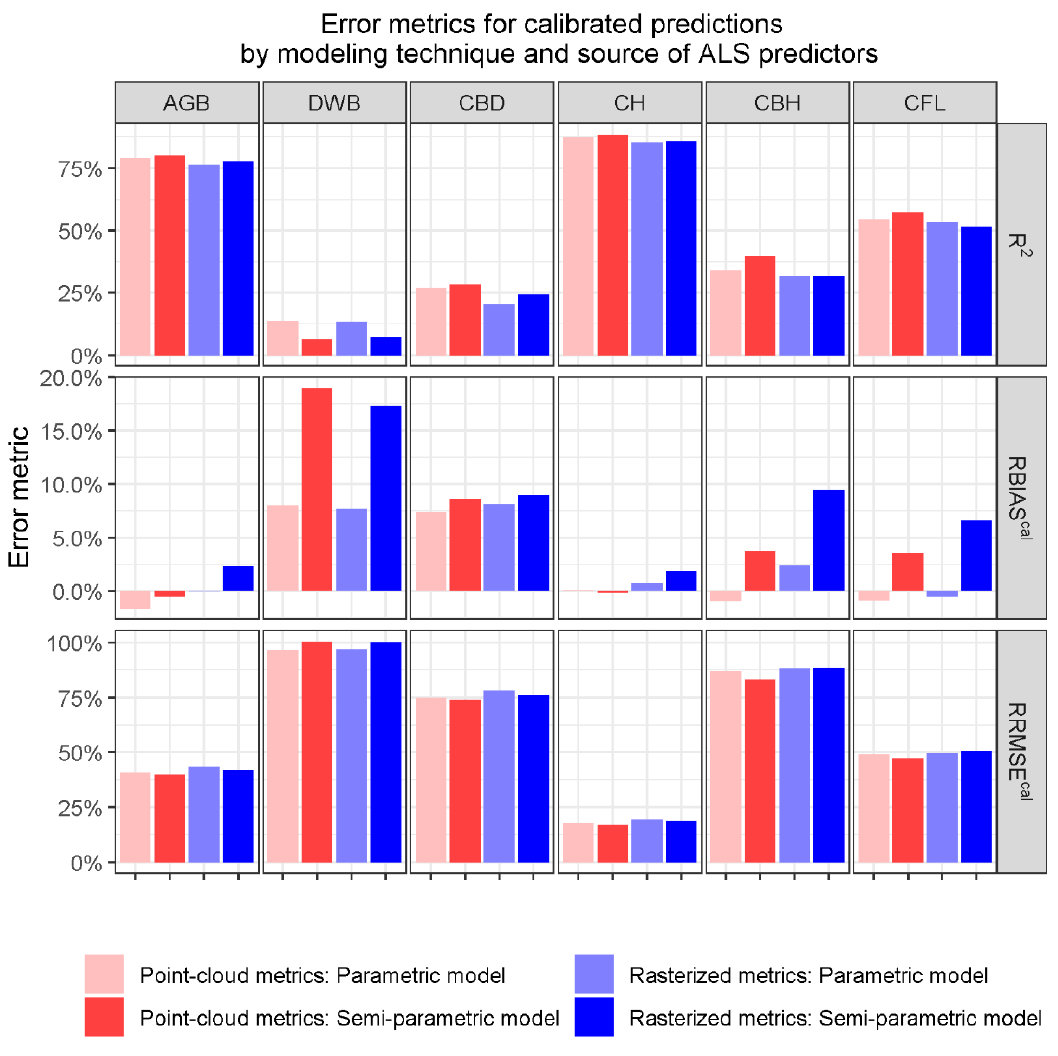
Figure 3. Relative root mean squared error ( RRMSE cal ), relative bias ( RBIAS cal ), and coefficient of determination ( R 2 ) for parametric models. Error metrics were calculated for models fitted with the entire dataset under consideration and predictions calibrated using all plots in the corresponding ALS acquisition, which were measured either in the year that the ALS data acquisition was finished, or in the two previous years. Model response variables are: aboveground biomass (AGB), downed woody biomass (DWB), canopy bulk density (CBD), canopy height (CH), canopy base height (CBH), and canopy fuel loading (CFL).